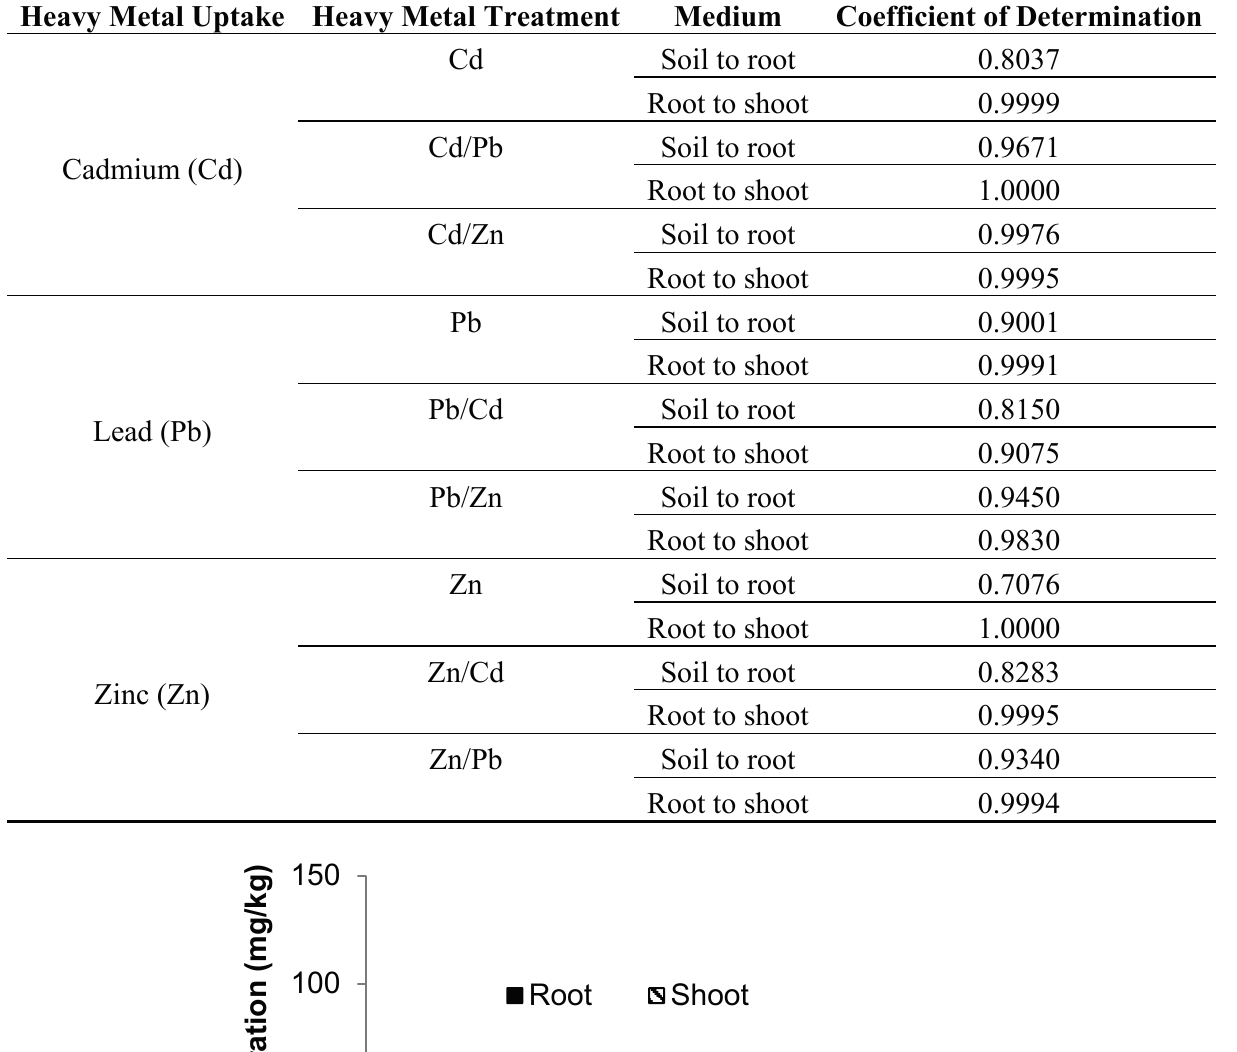
Table 3. Linear regressions model for heavy metal concentrations in soils, roots and shoots.